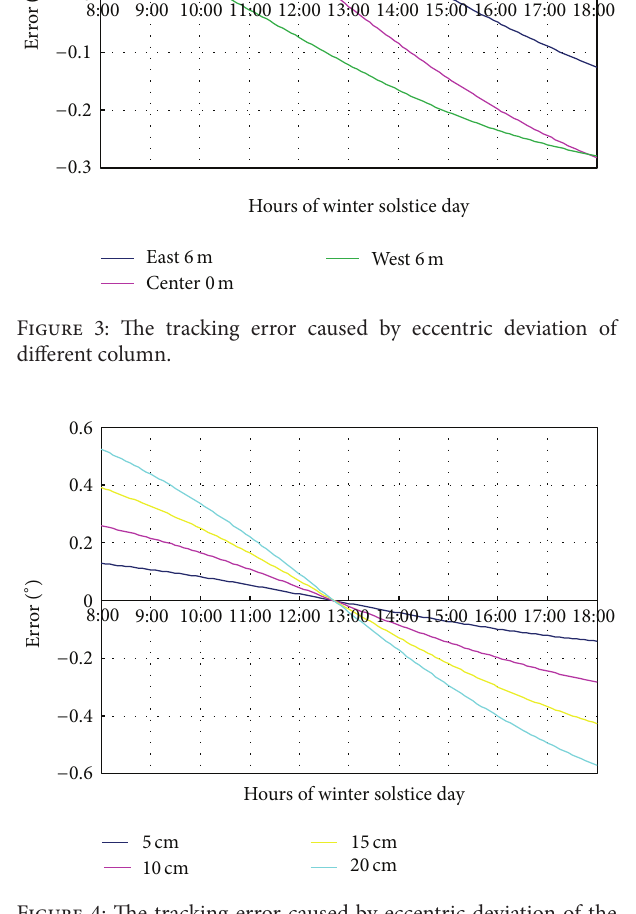
Figure 4: The tracking error caused by eccentric deviation of the middle